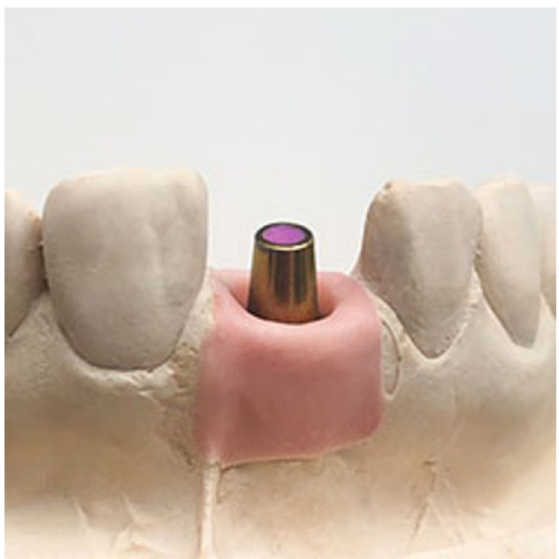
Fig. 1 Dental cast. Dental cast with gingival mask and dental abutment in the position of the maxillary right central incisor.